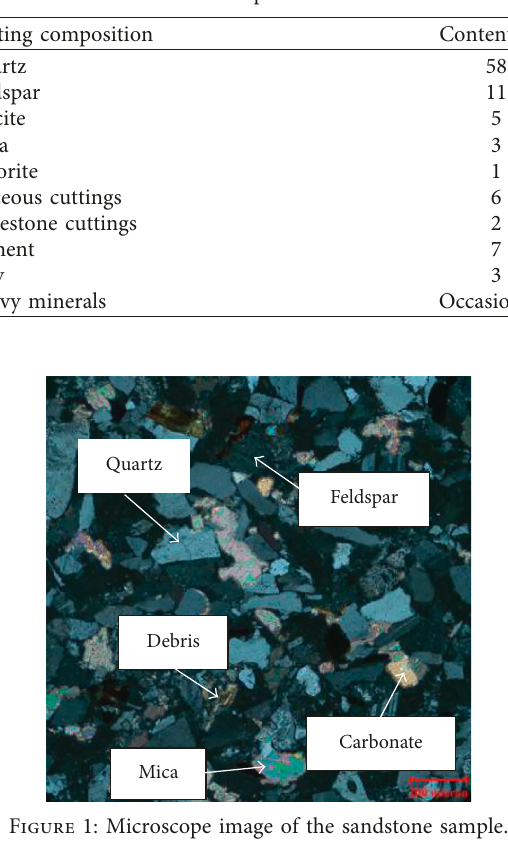
Table 1: Debris components and contents.